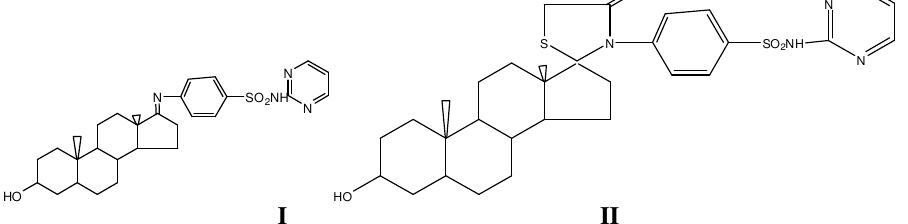
Figure 1 . Chemical structures of sulfadiazine- imino- steroid ( I) and spiro 4-thiazolidinone- 2, 2-steroid ( II